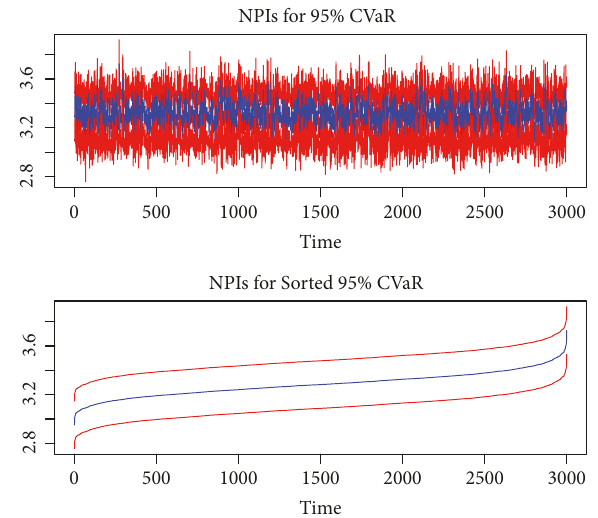
Figure 3: The red lines in the first and second panels show the upper and lower prediction intervals, and the blue lines in both cases show the 95%